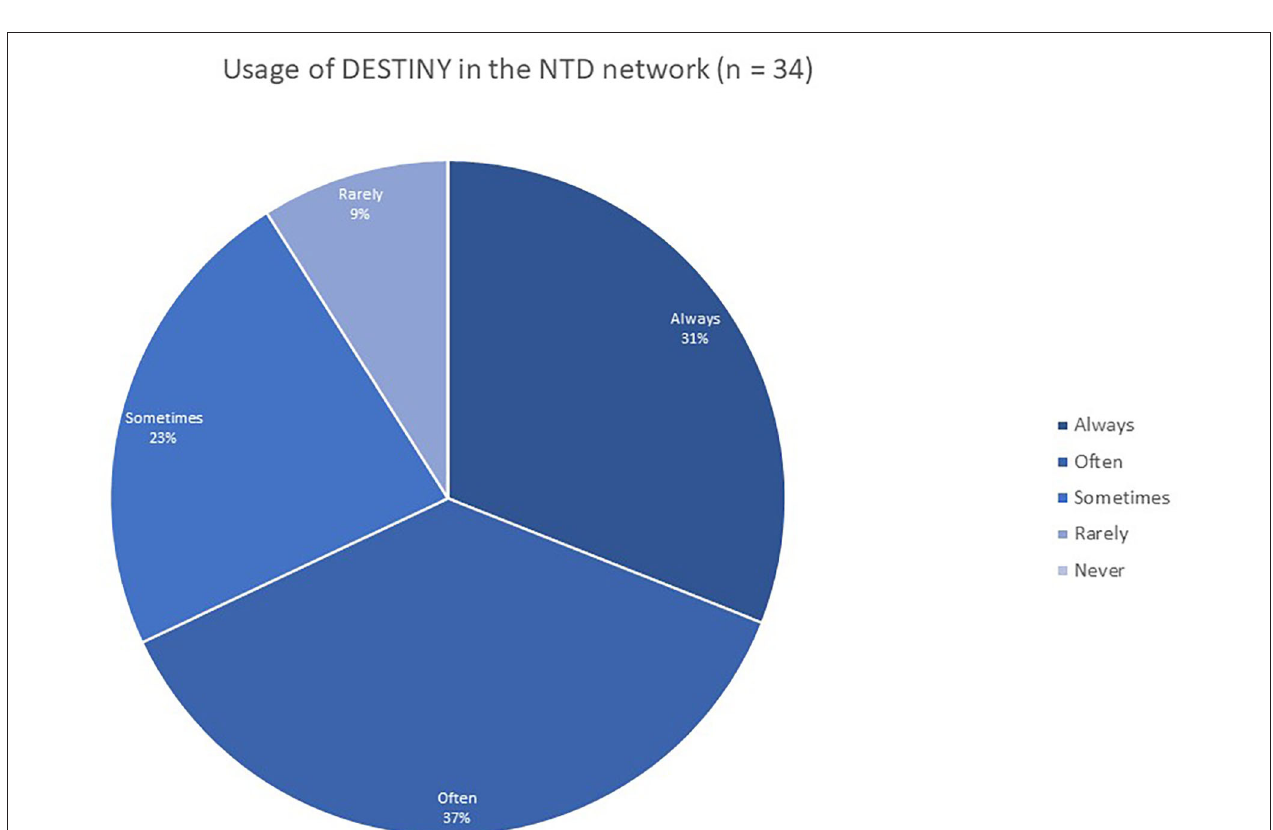
FIGURE 6 | Usage of DESTINY in the NTD network.